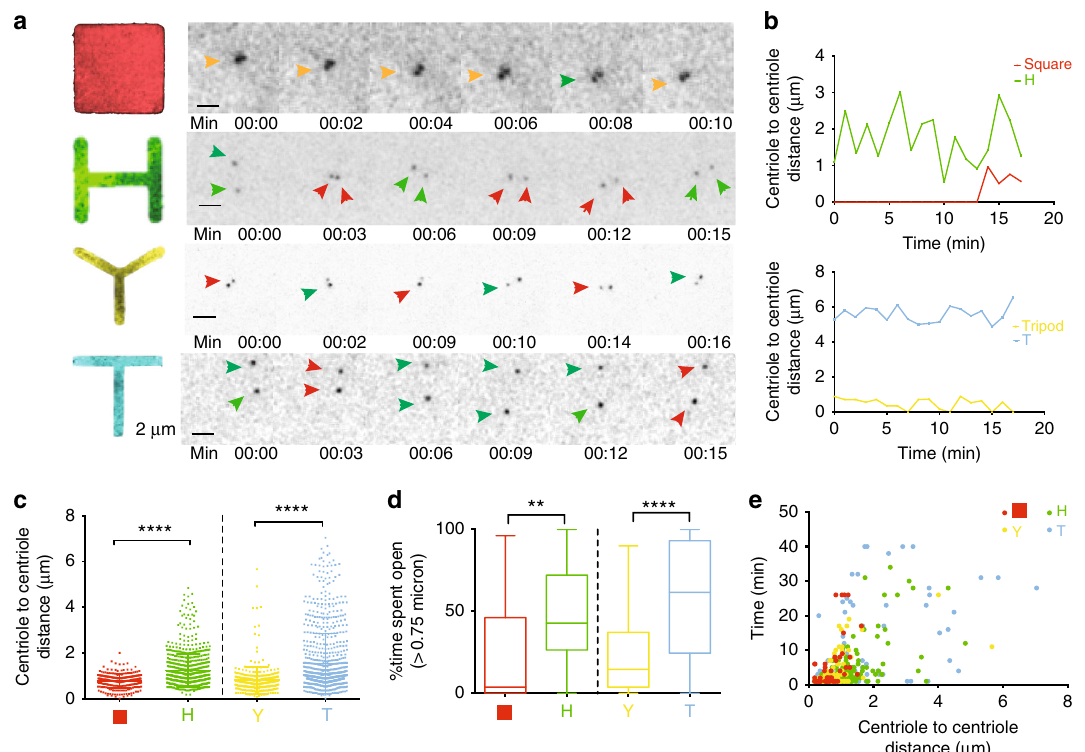
Fig. 3 Acto-myosin force organization differentially controls dynamics of centriole separation. a Selected frames from time-lapse movies of cells expressing C1-GFP (Scale bar = 2 μ m). Orange arrows indicate centrioles that maintain a stable distance over time, green indicates an increase in distance, red indicates a decrease in distance. Time is in minutes (min). Images correspond to Supplementary Movies 1 – 4. b Centriole-to-centriole distance plotted over time for the respective videos. c Centriole-to-centriole distance for all cells and time points (20 – 30 time points in each cell). d Percentage of time spent open (a centrosome is de fi ned as “ open ” if centriole-to-centriole distance is above 0.75 μ m). e Open time versus centriole-to-centriole distance for all the cells imaged on the micropatterns (Square n = 23 cells; H n = 46 cells; Tripod n = 39 cells; T n = 37 cells). Error bars represent s.e.m.; p -values were obtained with unpaired two-tailed t -test; **** p < 0.0001: ** p <